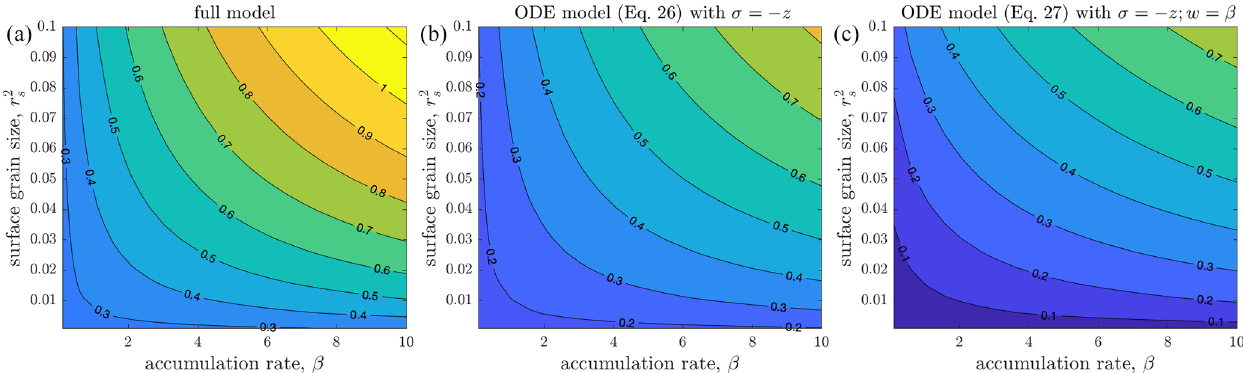
Figure 6. Firn thickness z 830 as a function of surface grain-size r 2 s and accumulation rate β (all nondimensional) from (a) the full model using the same parameters as used to produce Fig. 4; (b) a simplified version of the ODE model that assumes δ = 0 and σ = − z (Eq. 26); and (c) a further simplification of the ODE model that assumes δ = 0, σ = − z , and w = − β (Eq. 27). All three panels show the same relationship between surface grain size, accumulation, and firn thickness: as surface grain size increases, the firn thickness depends more strongly on the accumulation rate (see also Fig. 5).